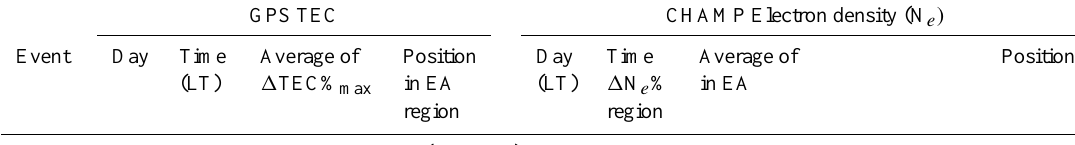
Table 3. The ionospheric anomalies detected before the 4 large earthquake events. The day is relative to the earthquake day. GPS TEC CHAMP Electron density (N e